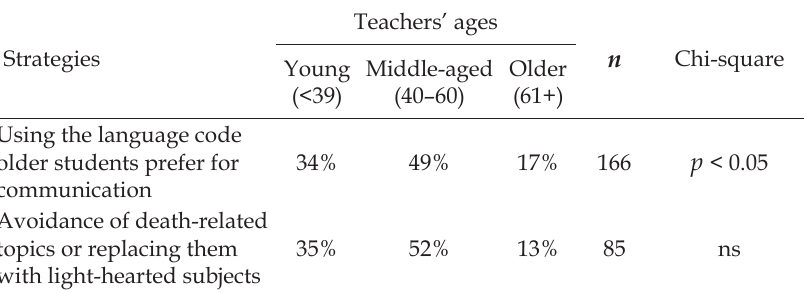
Table 4. Code-selection and mitigation of death-related topics ( N = 213) Strategies Using the language code older students prefer for communication Avoidance of death-related topics or replacing them with light-hearted